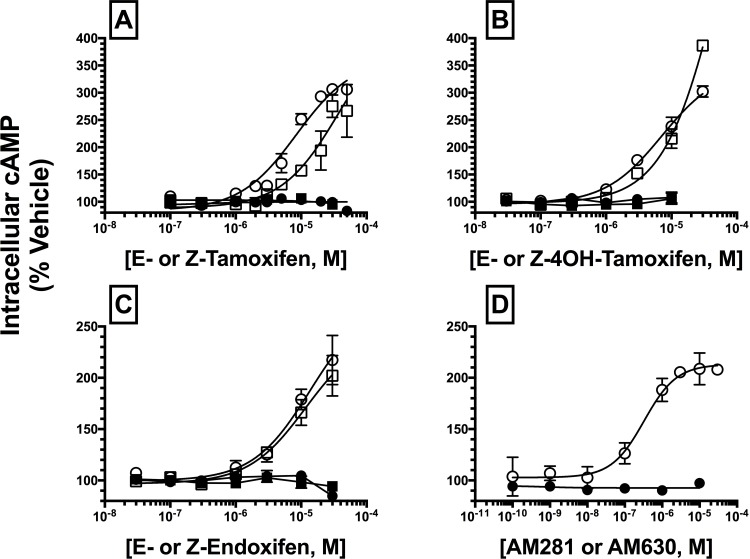
Modulation of forskolin-stimulated cAMP production by SERM isomers in intact CHO-hCB1 and CHO-hCB2 cells.The potency (IC50) and efficacy (EMAX) for modulation of forskolin-stimulated AC was evaluated by analyzing concentration-effect curves for SERMs in intact CHO-hCB1 and CHO-hCB2 cells. All IC50 and EMAX values (mean ± SEM) were derived from non-linear regression analysis of the curves shown in [A-D] and are presented in Table 2 with statistical analysis. For panels [A-C], filled squares and circles represent modulation of adenylyl cyclase activity by E- and Z-isomers acting at hCB1Rs, respectively, while open squares and circles demonstrate modulation by E- and Z-isomers at CB2Rs. In panel [D], modulation of adenylyl cyclase activity by the selective CB1R inverse agonist AM-281 (filled circles) and CB2R inverse agonist AM-630 (open circles) is depicted.